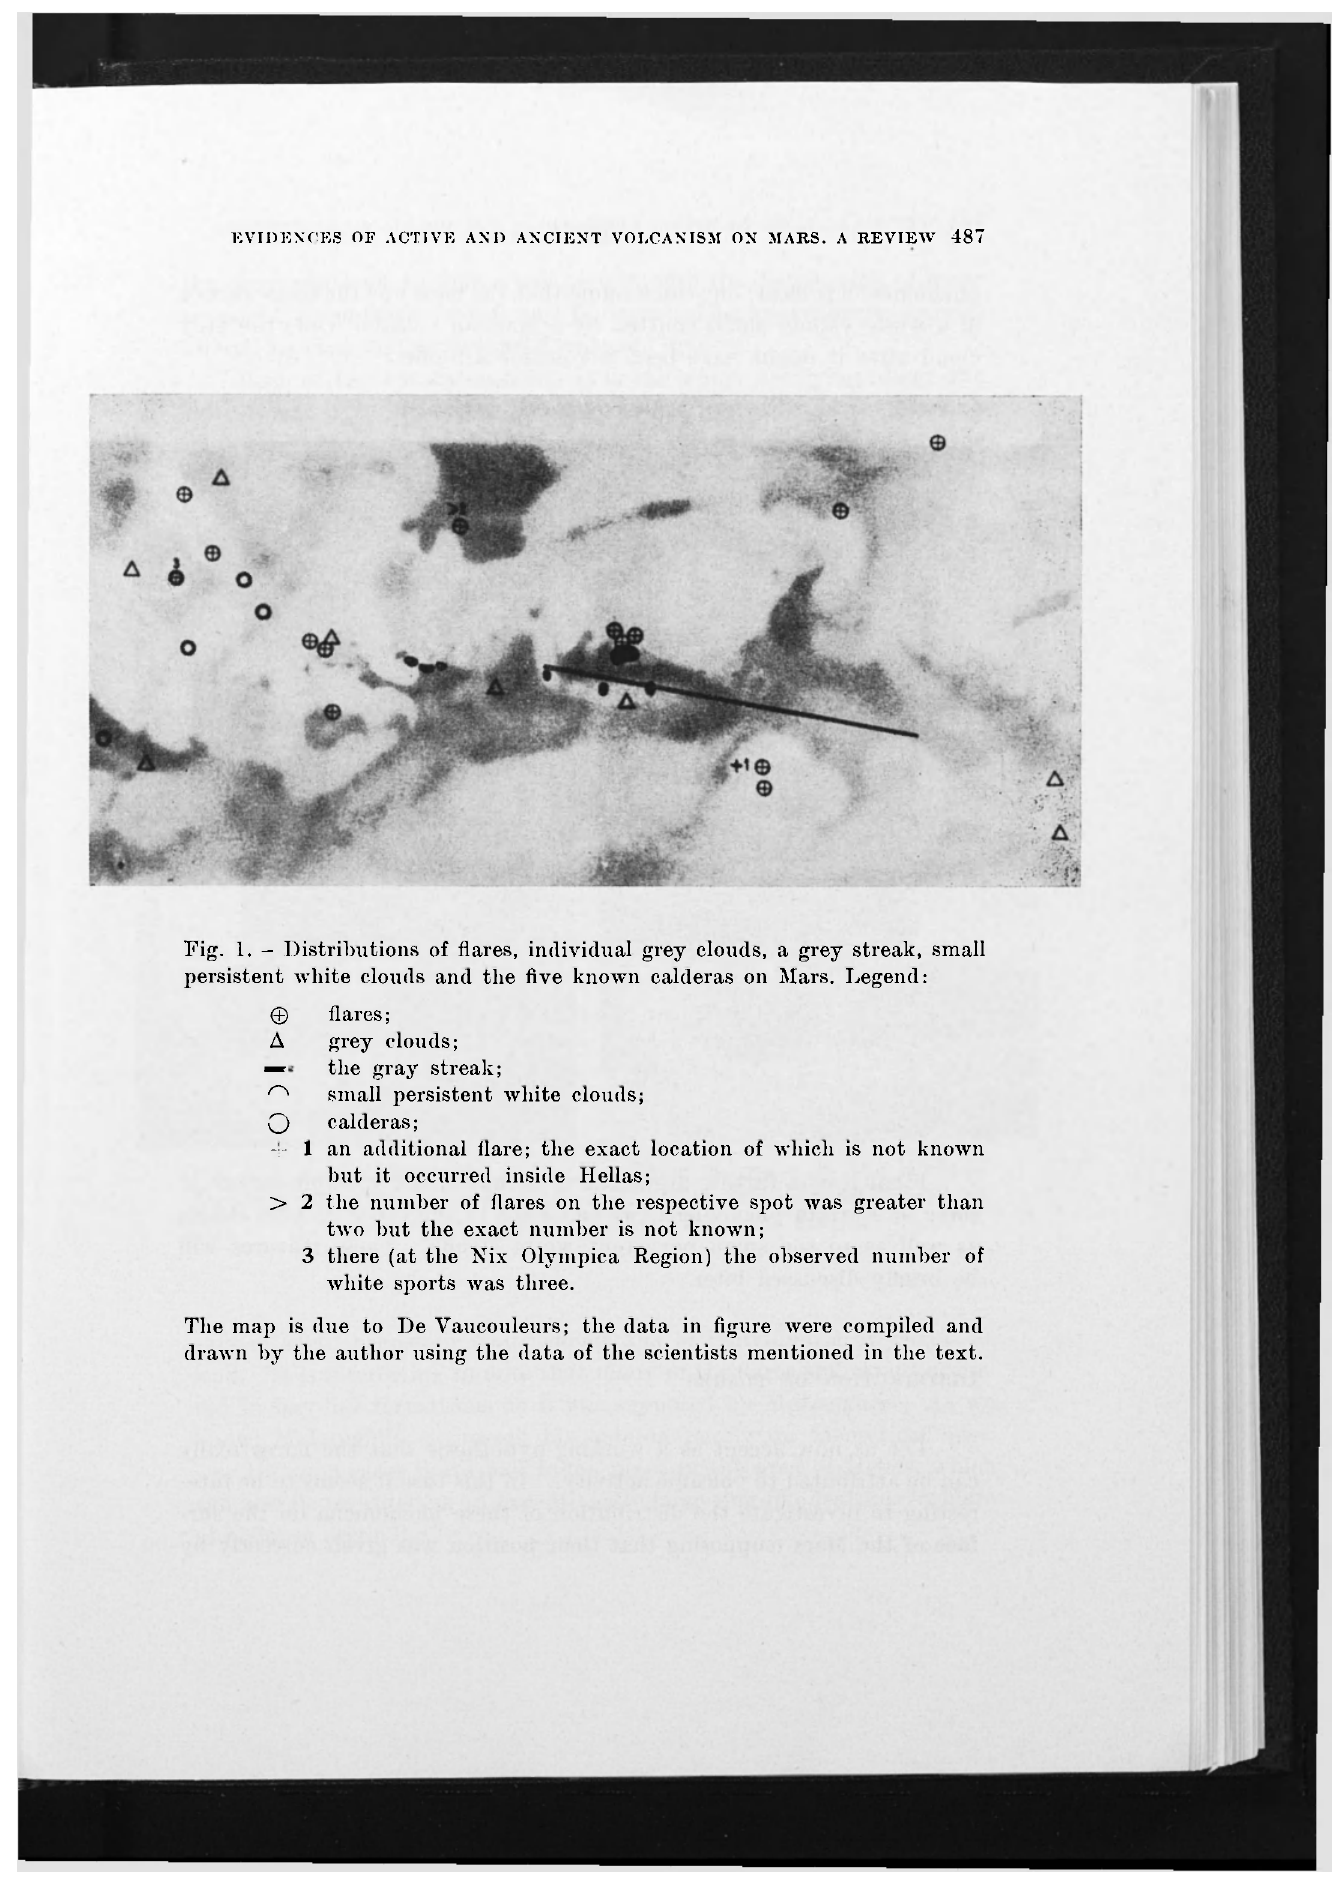
Fig. 1. - Distributions of flares, individual grey clouds, a grey streak, small persistent white clouds and the five known calderas on Mars.